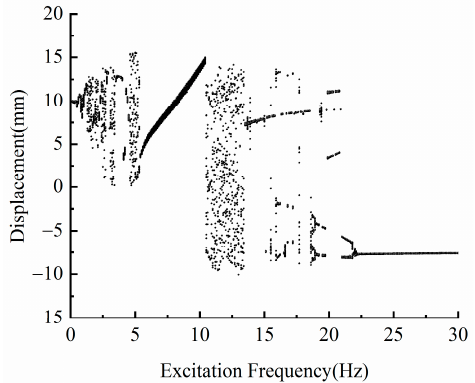
Figure 7. bifurcation diagram of the system at different excitation frequencies. Figure 7. Bifurcation diagram of the system at different excitation